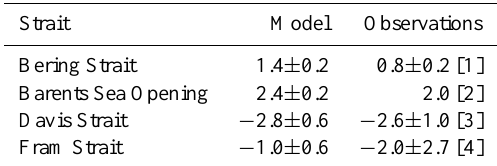
Table 1. Mean simulated and observed oceanic transports through the Arctic straits (Sv). Where possible, the standard deviation of the annual time series is given. Transports into the Arctic Ocean are